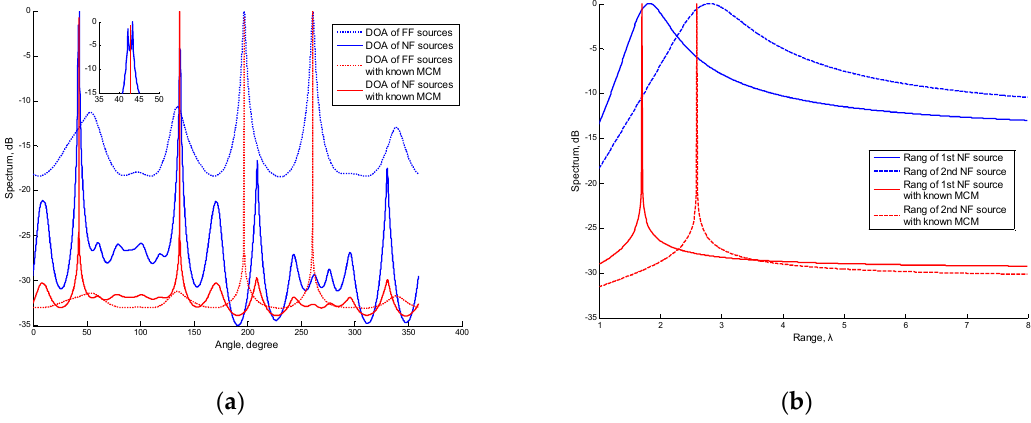
Figure 3. ( a ) Azimuth spectrum of covariance differencing (CD)-like at ϕ= 65°; ( b ) Range spectrum of CD-like.